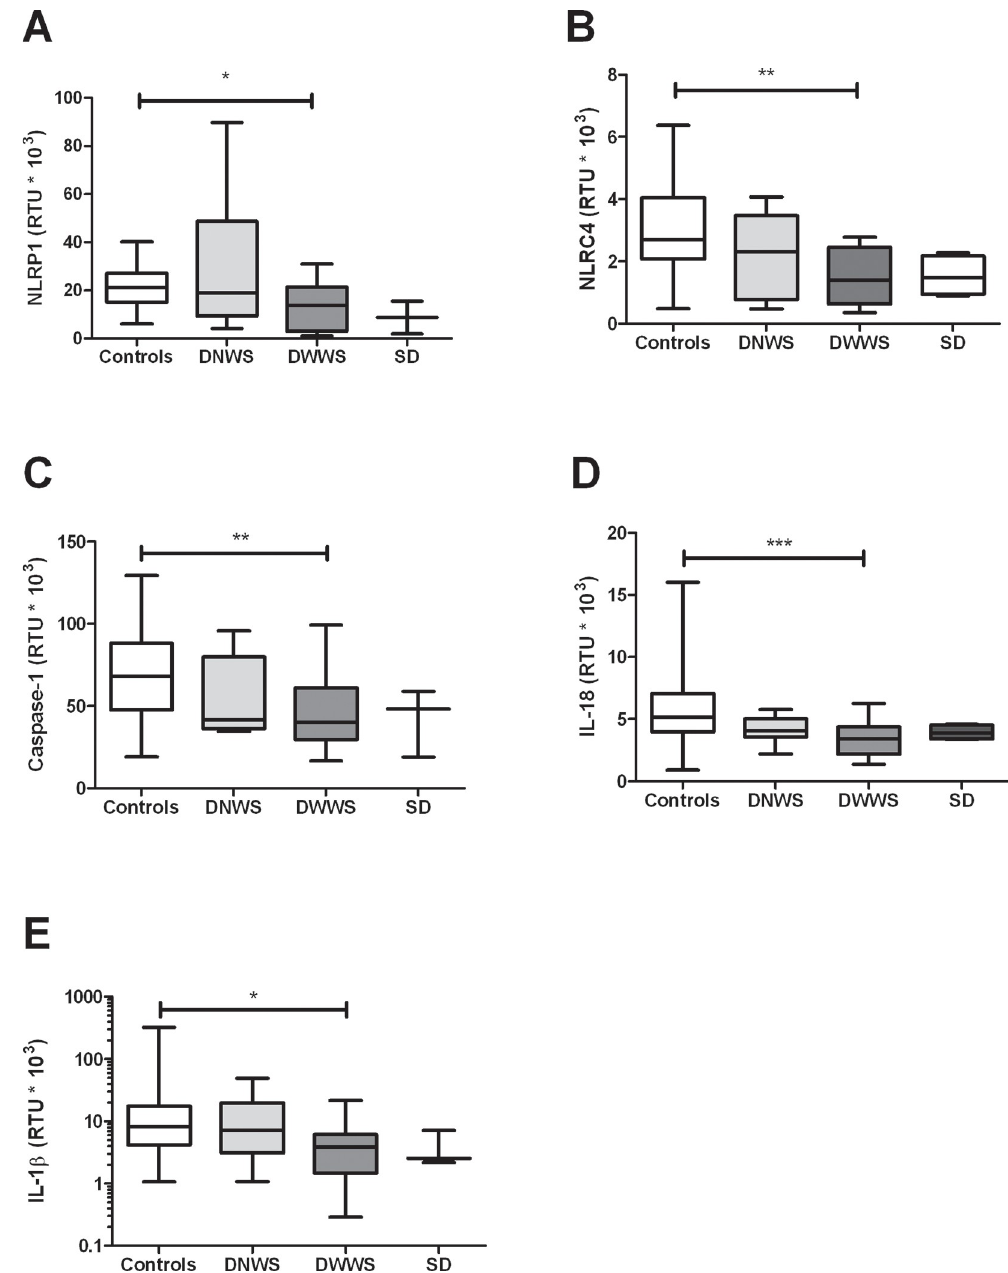
Fig 4. Inflammasome-related genes expression in dengue patients, according to clinical classification. The expression of (A) NLRP1, (B) NLRC4, (C) caspase-1, (D) IL-18 and (E) IL-1 β in PBMCs was quantified by real time PCR by duplicated. The β -actin gene was used as a constitutive gene to normalize the mRNA content. The results are presented as medians with maximum and minimum values (box and whisker plot). Statistical comparison was made using the Kruskal-Wallis test with a confidence level of 95% and post hoc tests (or multiple benchmarks) HDS of Dunn, were applied. Significant differences are represented at the top of the figure ( � p < 0.05; �� p < 0.01; ��� p <